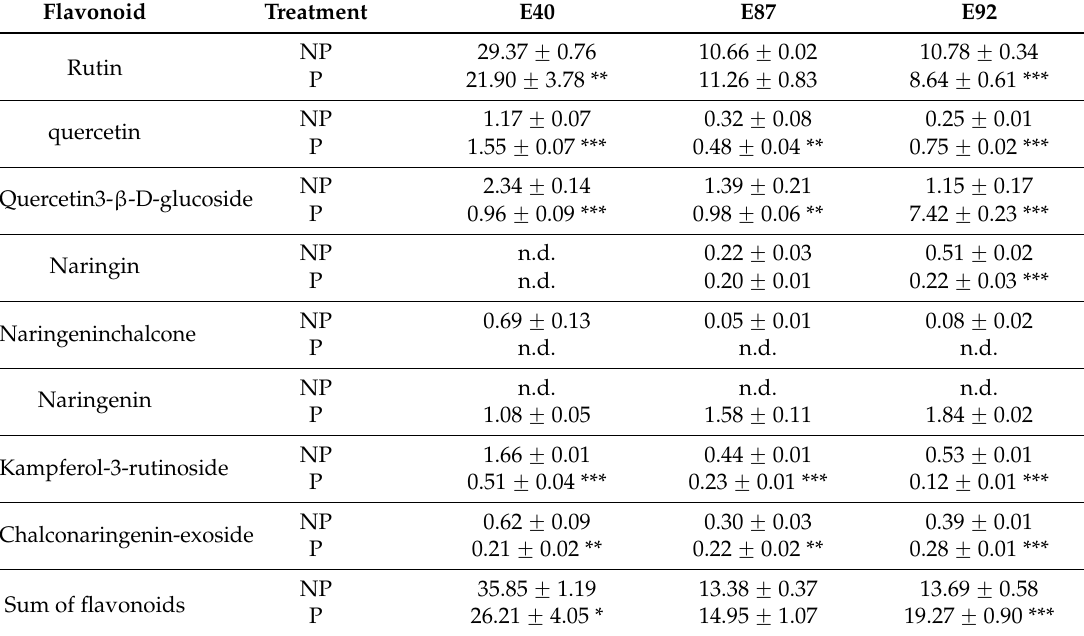
Table 4. Quantification of flavonoids in yellow tomato lines before (NP) and after (P) processing. Flavonoid